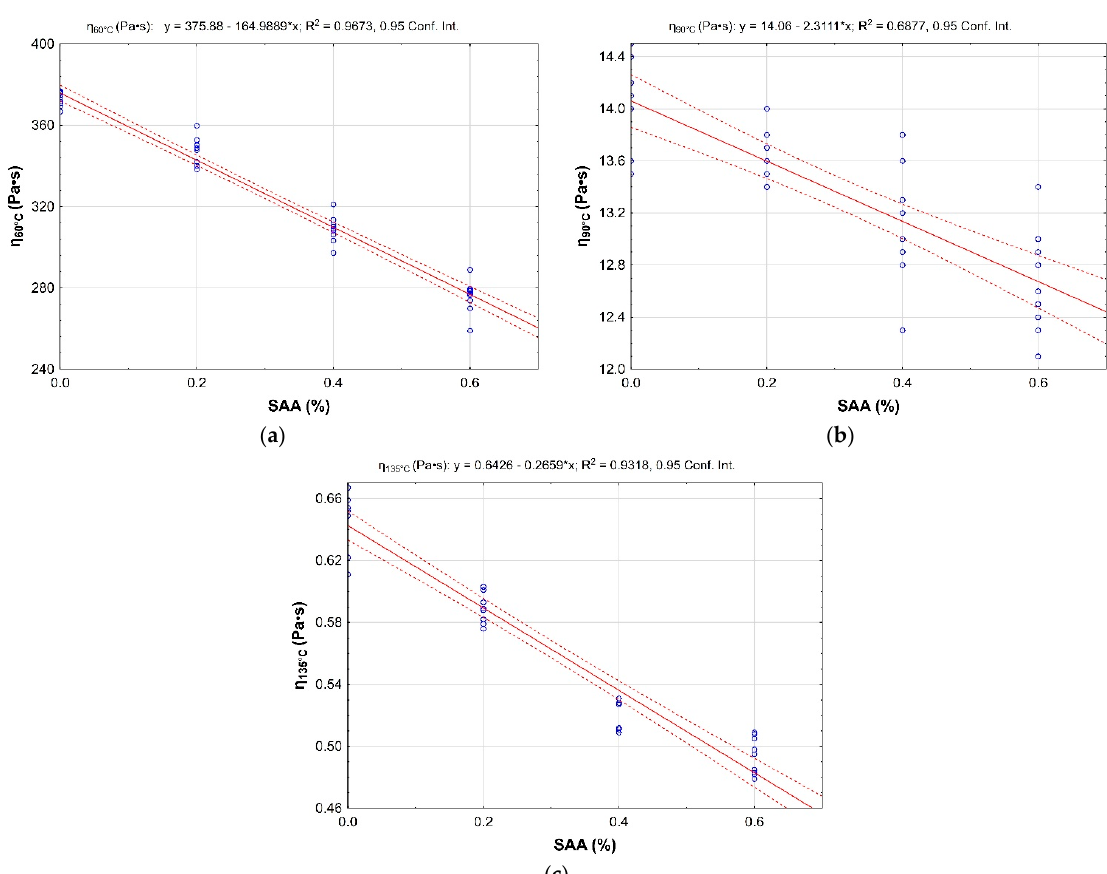
Figure 3. Effect of SAA on 50/70 bitumen viscosity versus test temperature a ) 60 °C, b ) 90 °C, and c ) 135 °C. The plots represent discrete results, linear approximation of the results and the 95% confidence intervals.